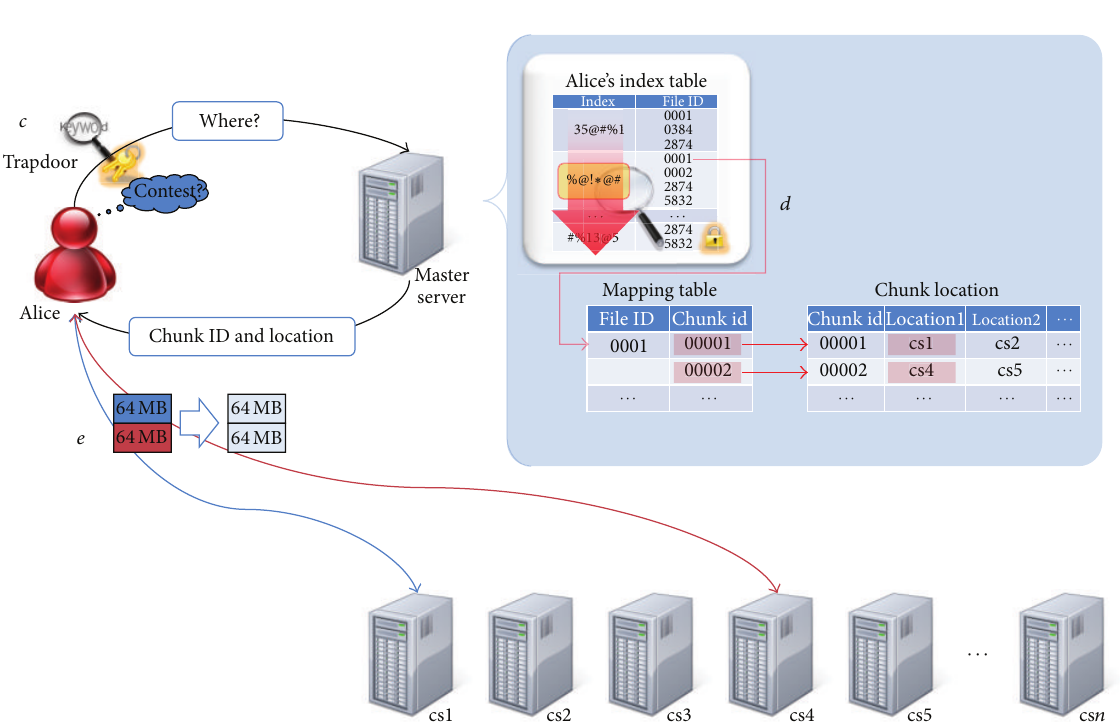
Figure 4: Storage scenario.